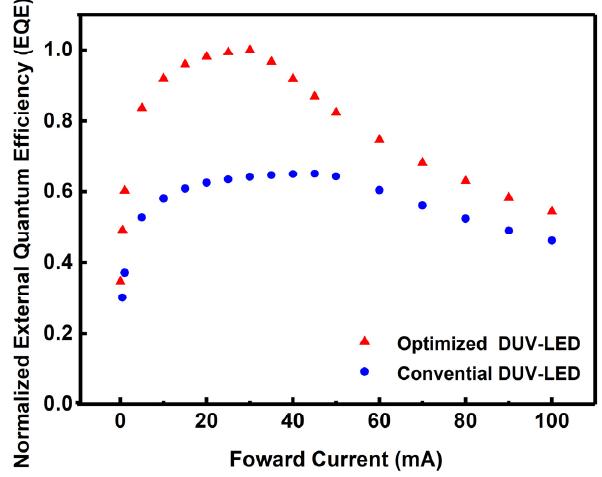
Figure 11. Measured external quantum efficiency (EQEs) of the DUV-LEDs packaged through the conventional and proposed packaging methods plotted against forward current.